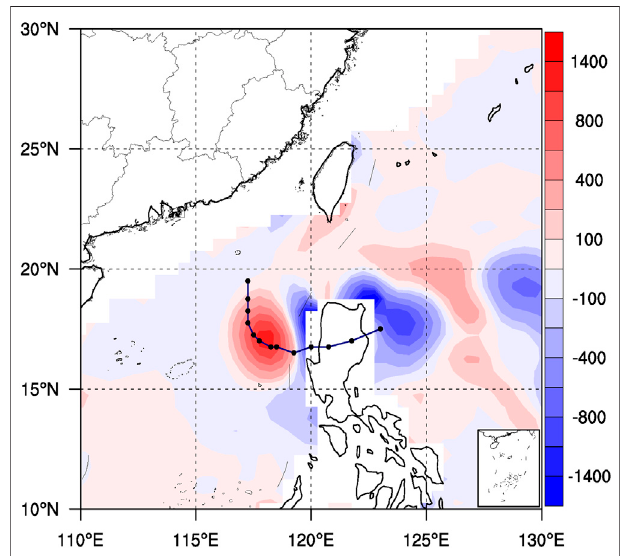
FIGURE 9 | The distribution of OHC anomalous (shaded contours, Unit: J km − 2 ) at T-12. (Solid line with dots is the composed typhoon track).